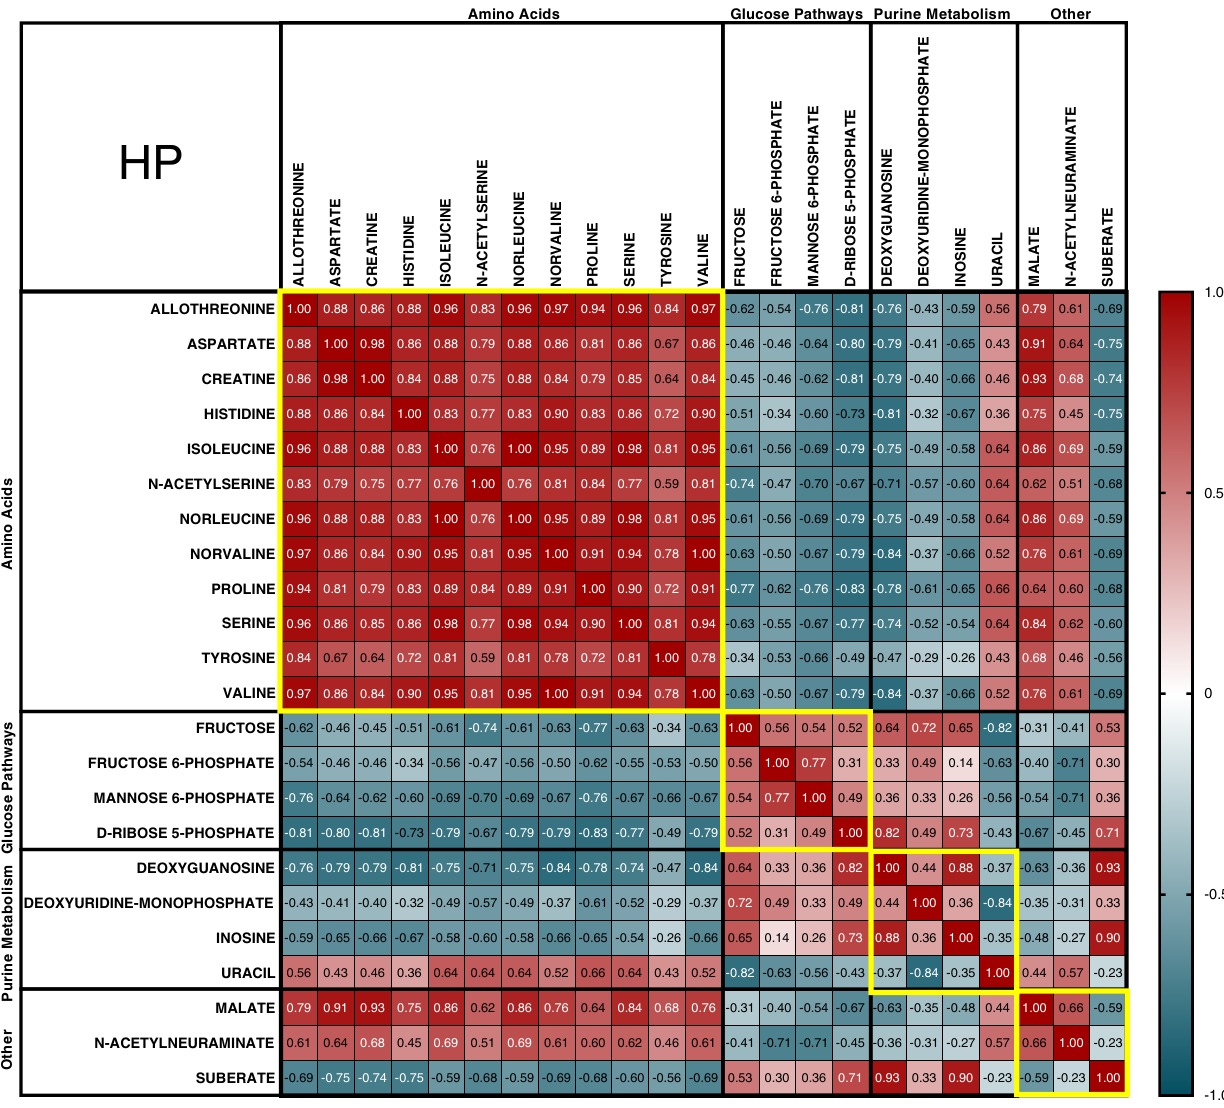
Fig. 5 HP metabolite correlation matrix. Matrix shows non-parametric Pearson correlation coef fi cient r values. Signi fi cant correlations are de fi ned as r > 0.5, p < 0.05; r = 0.5 – 0.6 are weak correlations, r = 0.6 – 0.7 are moderate correlations, r = 0.7 – 0.9 are strong correlations, and r > 0.9 are very strong correlations. All correlations of r < 0.5 had a p value >0.05. The red colour denotes positive correlations, while blue denotes negative correlations; the darker the colour, the stronger the